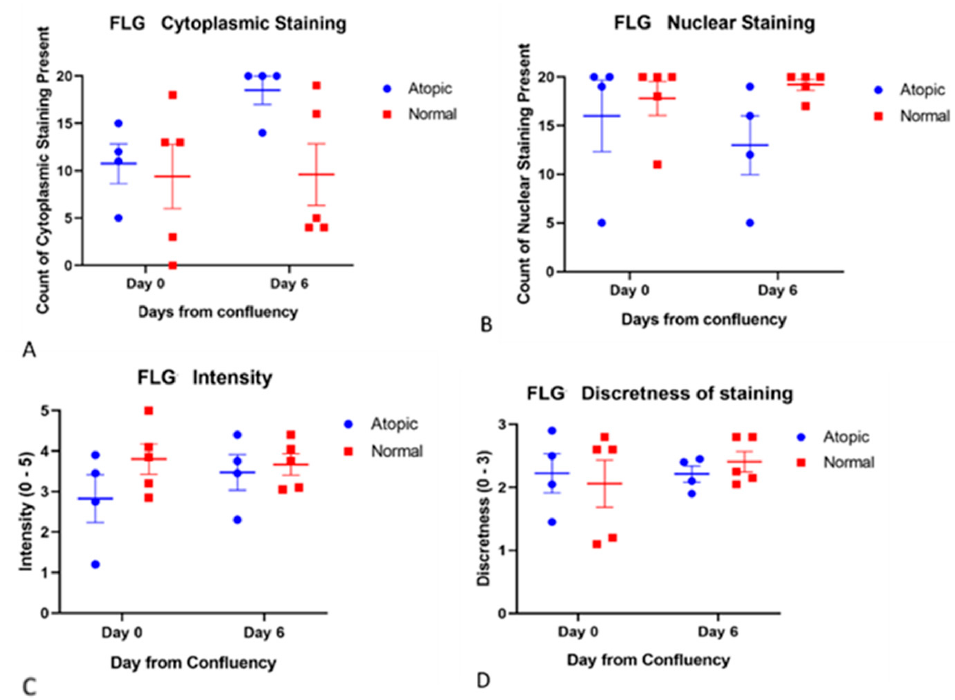
Figure 5. Filaggrin staining was scored for location, intensity, and discreteness by four observers unaware of the source of the cells ( A – D ). No statistically significant differences were found between groups and from D0 to D6 for any of these parameters. For this scoring, four atopic cell cultures and five normal cell cultures were used.